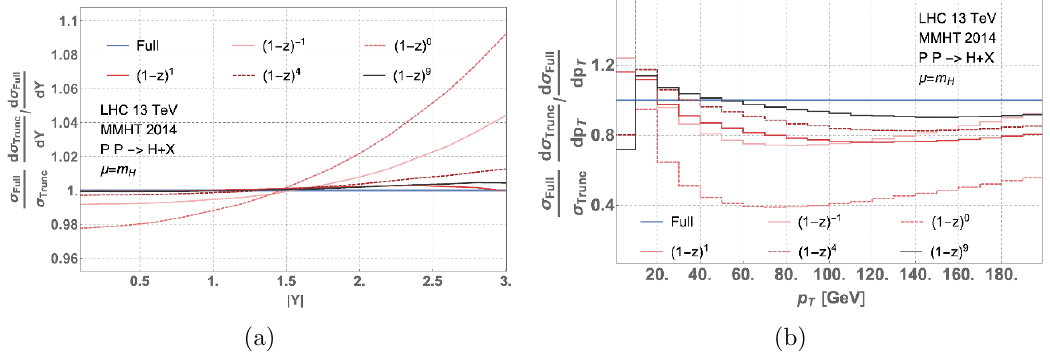
Figure 4. NNLO absolute rapidity (left) and transverse momentum (right) distribution for the Higgs boson. The blue line represents the exact result. Increasingly darker shades of red represent higher and higher truncation order of the threshold expansion. All lines are normalized to the exact NNLO distributions. The expanded distributions were reweighted such that their cumulant reproduces the unexpanded NNLO cross